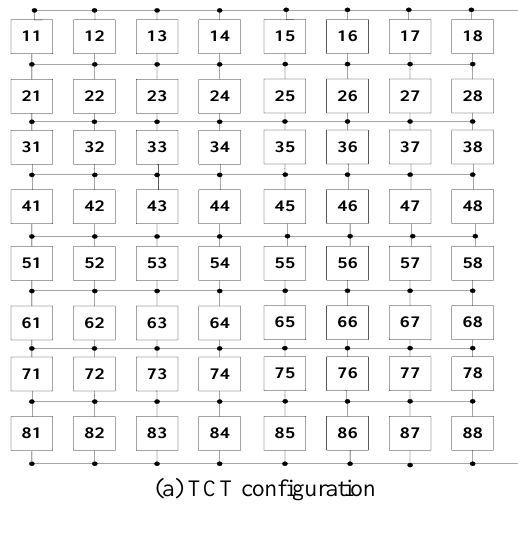
(e) SM-TCT configuration Figure 2(a)-(e) Symmetric matrix: Properties As illustrated in Figure 2(a)-(e), the arithmetic addition of each row-column is shown to be 36. In addition, as shown in Fig. 2(d), the recurrence of opposite 4x4 size matrix elements exists. Moreover, there is a repeat of inverse 4x4 size matrix components as shown in Fig. 2(d). Accordingly, the characteristics are validated for 8x8 size SM. The row amount and column length of the 8x8 size PV array is depicted by the first and second digits accordingly. The methodology for reconfiguring TCT in SM-TCT connections is shown in Figure 3(a)-(b). The proposed configuration reallocates the shadowing effect through dispersion over the modules in an array and shows momentous reduction in shading area of PV modules in different rows and columns, leading to enhancement in the system performance. It's obvious from Figure 3(b) the 22- number PV module (2nd row and 2nd column) is physically situated in the first and successive second rows in place of second row-column. So, similar methodology is executed for the entire PV panels in an array